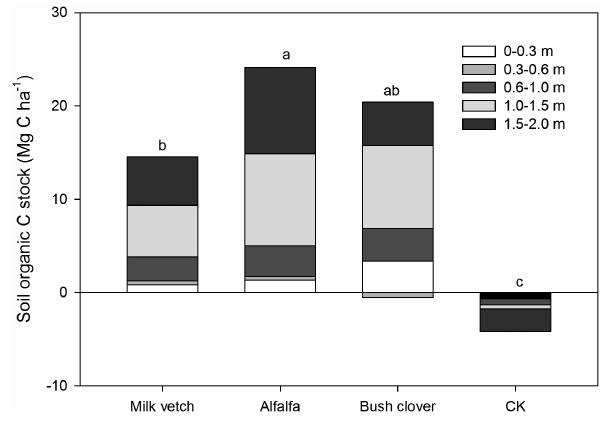
Figure 4. The soil organic carbon amount (stock) under milk vetch, alfalfa, bush clover and under bare soil (CK) over the upper 2m of the soil profile. The lower case letters indicate significant differ- ences ( P <0.05) between forage types and bare soil (CK) within a year. IV denotes initial value, the soil organic carbon stock in May 2004. Bars give + one standard error of the mean ( n = 3).